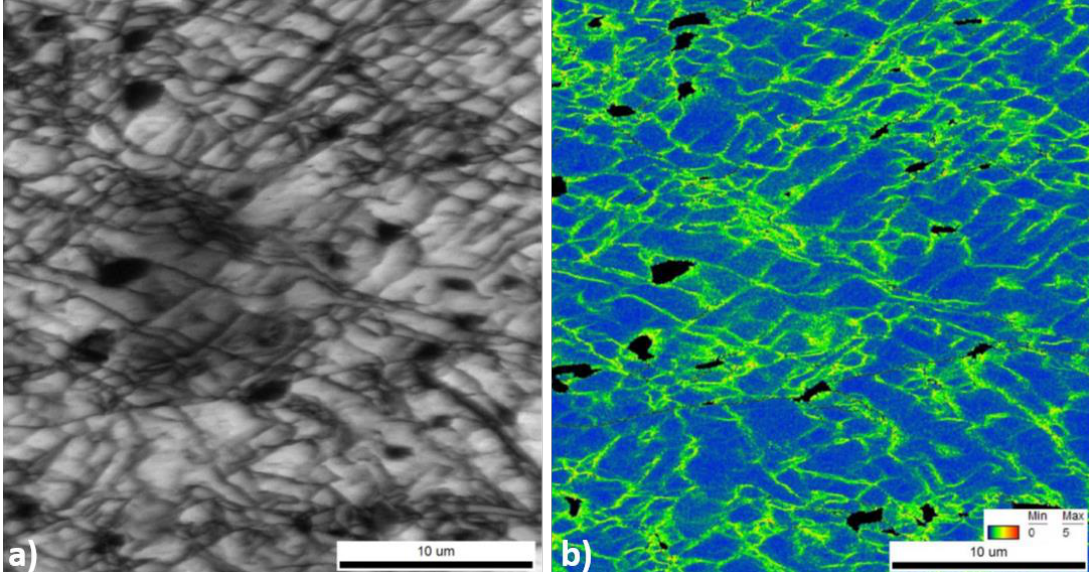
Figure 4. Microstructure of AA6082 after cold deformation determined by electron backscattered diffraction (EBSD) showing the cells in the ( a ) image quality (IQ) as well as ( b ) in the Kernel map. Black non-indexed areas represent the intermetallic positions.